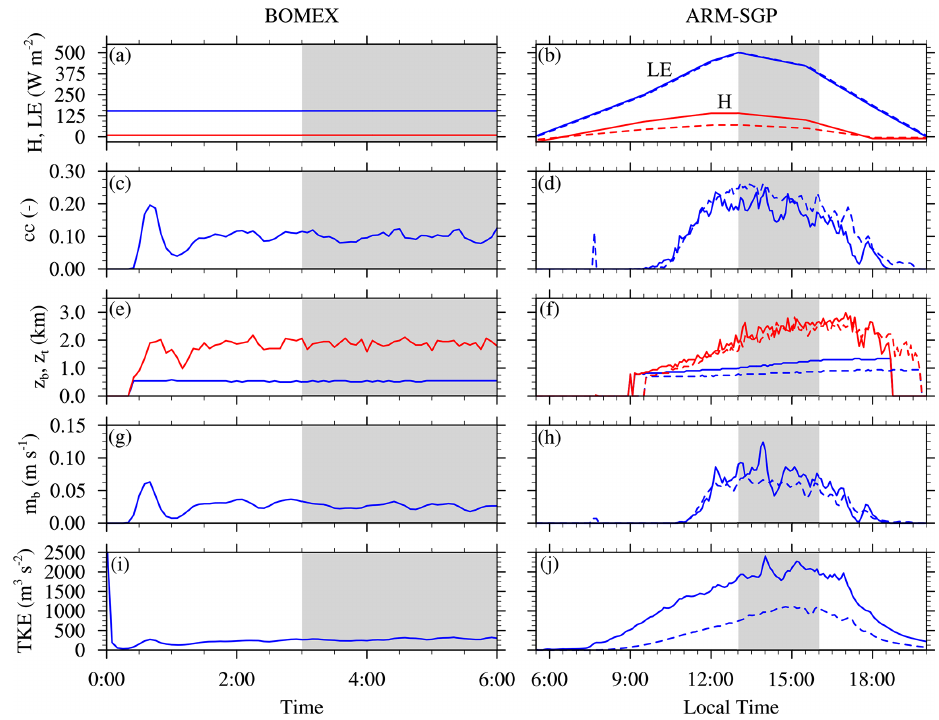
Figure 12. Same as Fig. 1 but in addition the time series of the diurnal cycle of the ARM-SGP experiments with a reduced H by 50% (RHFX50) are included in the dashed lines in the second column. The gray shading indicates the time window over which averages have been performed.